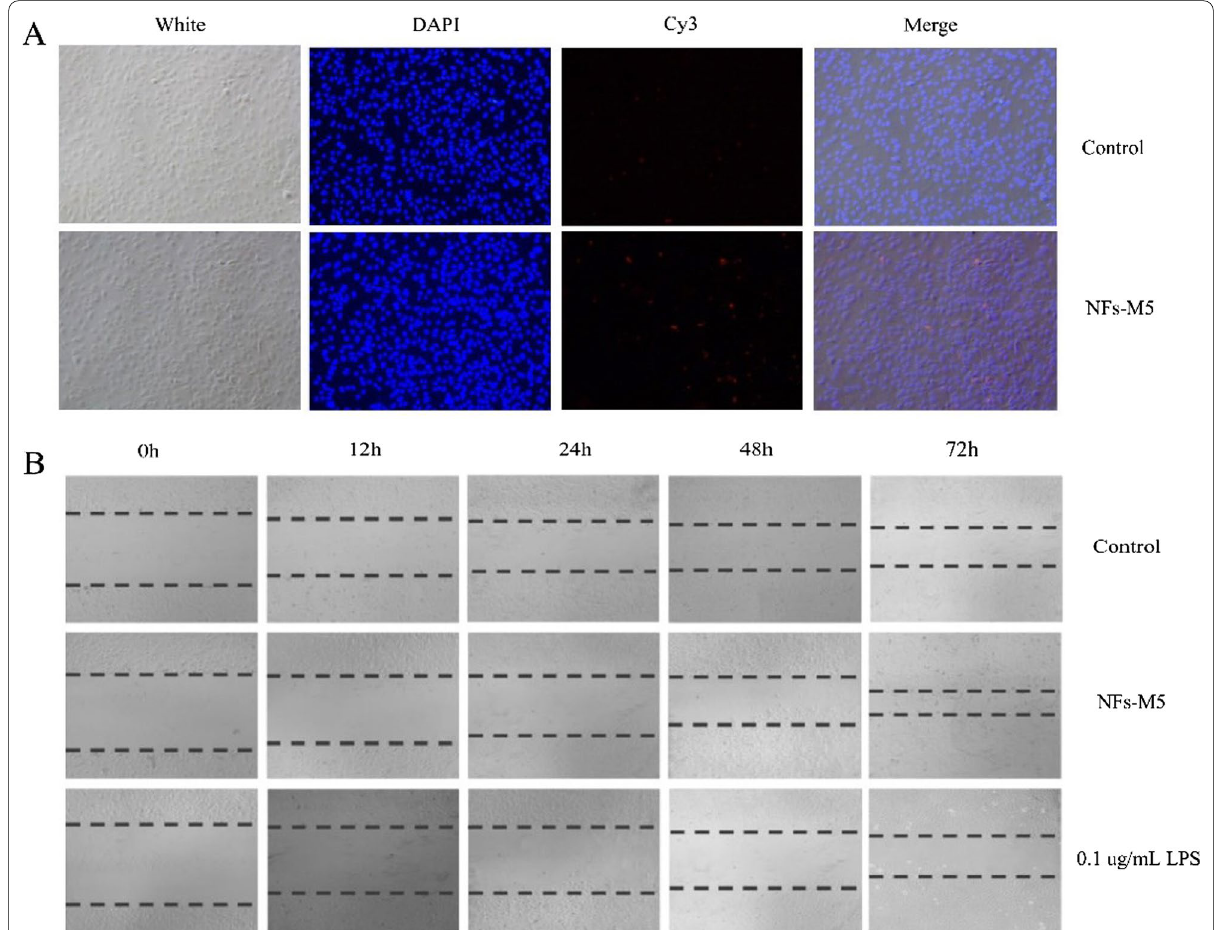
Fig. 5 A Fluorescence imaging of cells after treatment with NFs (M5) for 24 h (magnification 10 ). Cells stained with DAPI were imaged with an × exposure time of 10 ms, and those stained with Cy3 were imaged with an exposure time of 100 ms. B Results of scratch assays of cells treated with NFs (M5) at 0 h, 12 h, 24 h, 48 h, and 72 h (10 ×